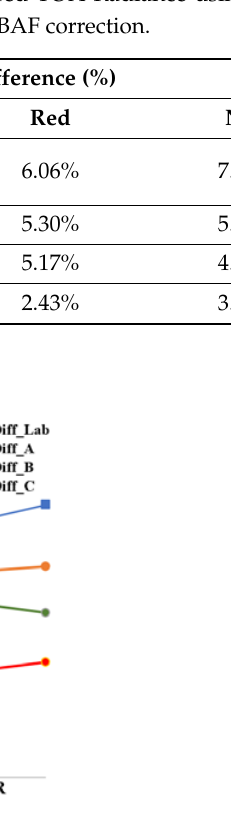
Figure 17. The relative difference between the Landsat-8 OLI TOA radiance after SBAF correction and the measured radiance with different coefficients.